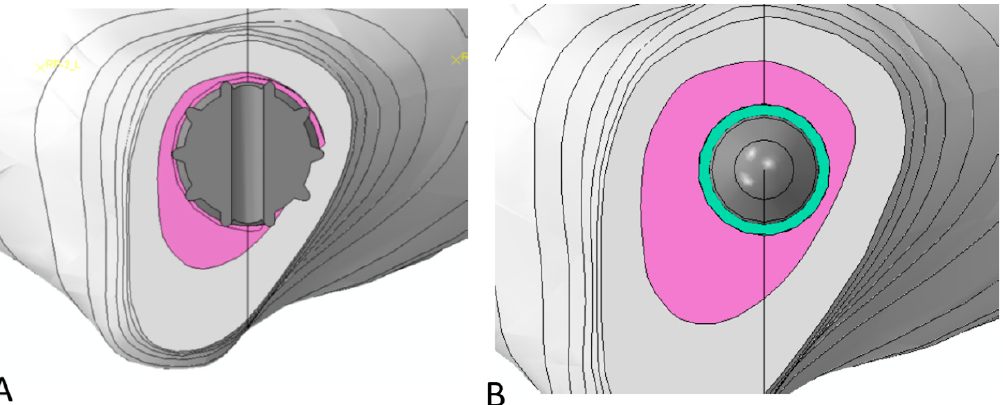
Figure 3. Interaction bone/stem: transversal section view of the area nearby the stem tip: ( A ) Press-fit stem engagement into the cortex; ( B ) cemented tibial stem; a cement layer of 1 mm (in light blue) was considered around the stem.